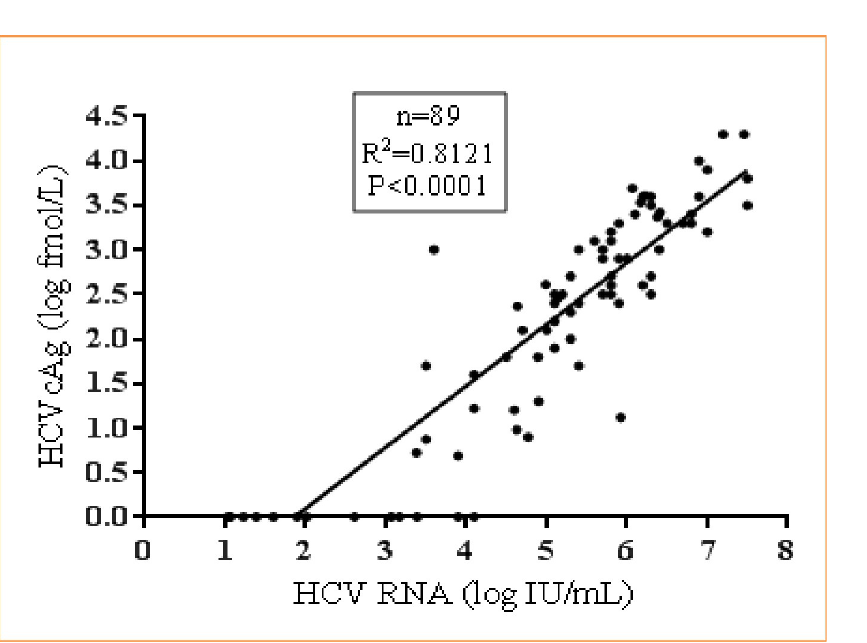
Fig 7. Correlation between HCV RNA and HCVcAg in common genotype samples.